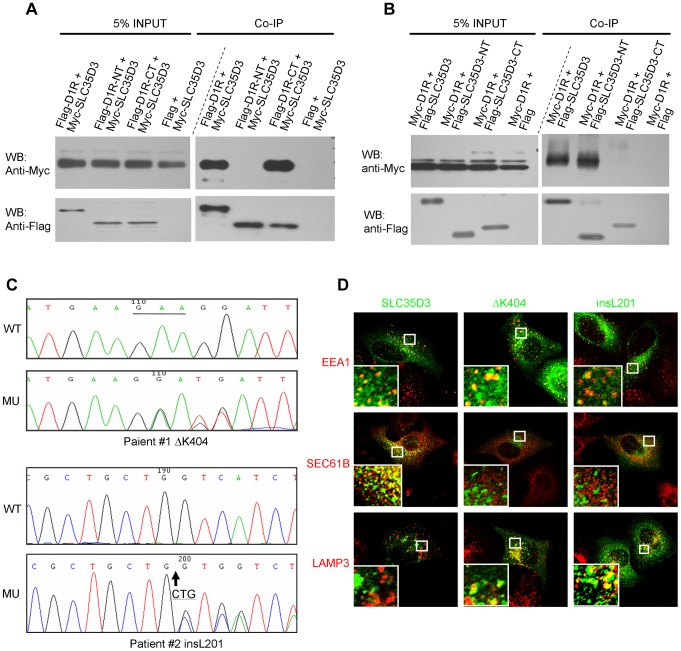
SLC35D3 interacts with D1R and mutations of SLC35D3 alter its subcellular distribution.(A) C-terminal D1R interacted with SLC35D3. Cell lysates with the co-expression of Myc-SLC35D3 and Flag-D1R (or Flag-D1R-NT (1–216aa), or Flag-D1R-CT (217–446aa)) were immunoprecipitated. Both the full-length D1R and the D1R-CT bound with Myc-SLC35D3. (B) N-terminal SLC35D3 interacted with D1R. Cell lysates with the co-expression of Myc-D1R and Flag-SLC35D3 (or Flag-SLC35D3-NT (1–301aa), or Flag-SLC35D3-CT (242–422aa)) were immunoprecipitated. Both the full-length SLC35D3 and the SLC35D3-NT bound with Myc-D1R. (C) Two heterozygous mutations were identified in two patients with MetS. WT: wild-type SLC35D3; MU: mutant SLC35D3. In patient #1, a 3-bp deletion (c.1209_1211delGAA) as underlined led to an in-frame deletion of K404. In patient #2, a 3-bp insertion (c.601_602insCTG) as the arrow indicated led to an in-frame insertion of L201. (D) In HEK293T cells, wild-type SLC35D3 was partially colocalized with EEA1 (early endosome) and SEC61B (ER), without colocalization with LAMP3 (late endosome/lysosome). The ΔK404 and insL201 mutations were mislocalized mainly on late endosomes/lysosomes.